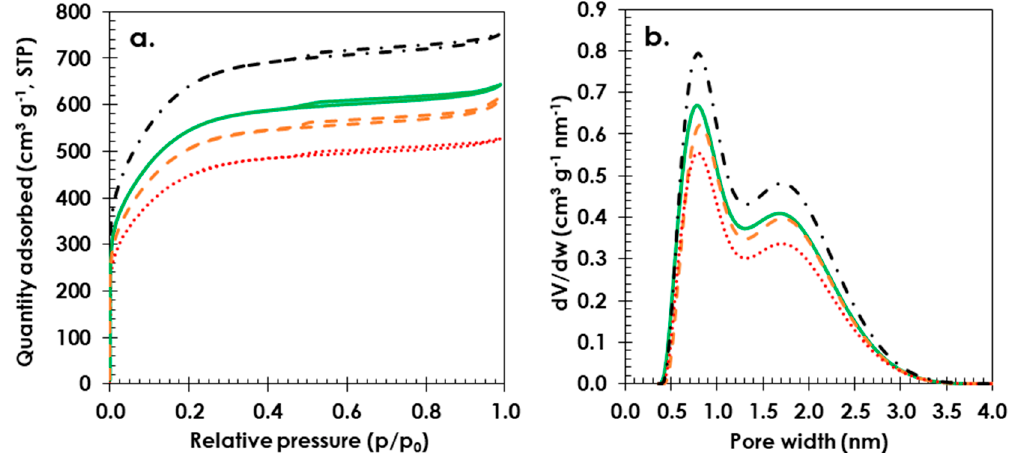
Figure 2. Gas adsorption data: ( a ) adsorption/desorption Brunauer-Emmett-Teller (BET) isotherms and ( b ) pore size distribution (PSD) curves for pristine activated carbon (Kuraray YP 80F) ( dashed-dotted black line ) and electrodes with different binders: starch ( solid green line ), PTFE ( dashed orange line ) and CMC ( dotted red line ). Composition of electrode material 80 wt. % activated carbon (YP 80F) 10 wt. % carbon black (Super C65) and 10 wt. % binder.